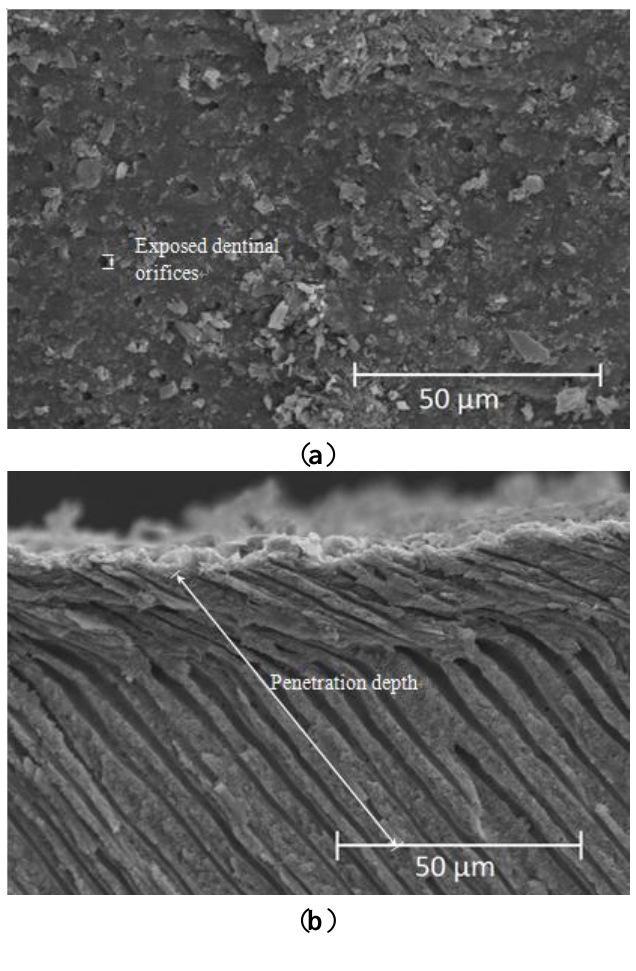
and ( b ) penetration